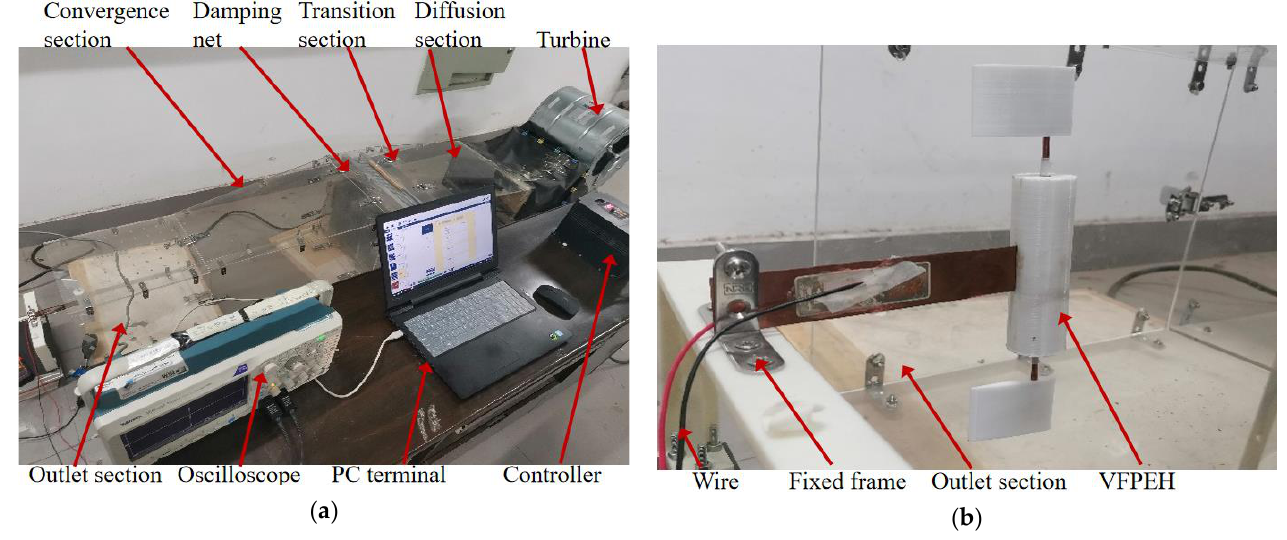
Figure 2. Experimental platform: ( a ) Energy harvest system; ( b ) Enlarged view of VFPEH.